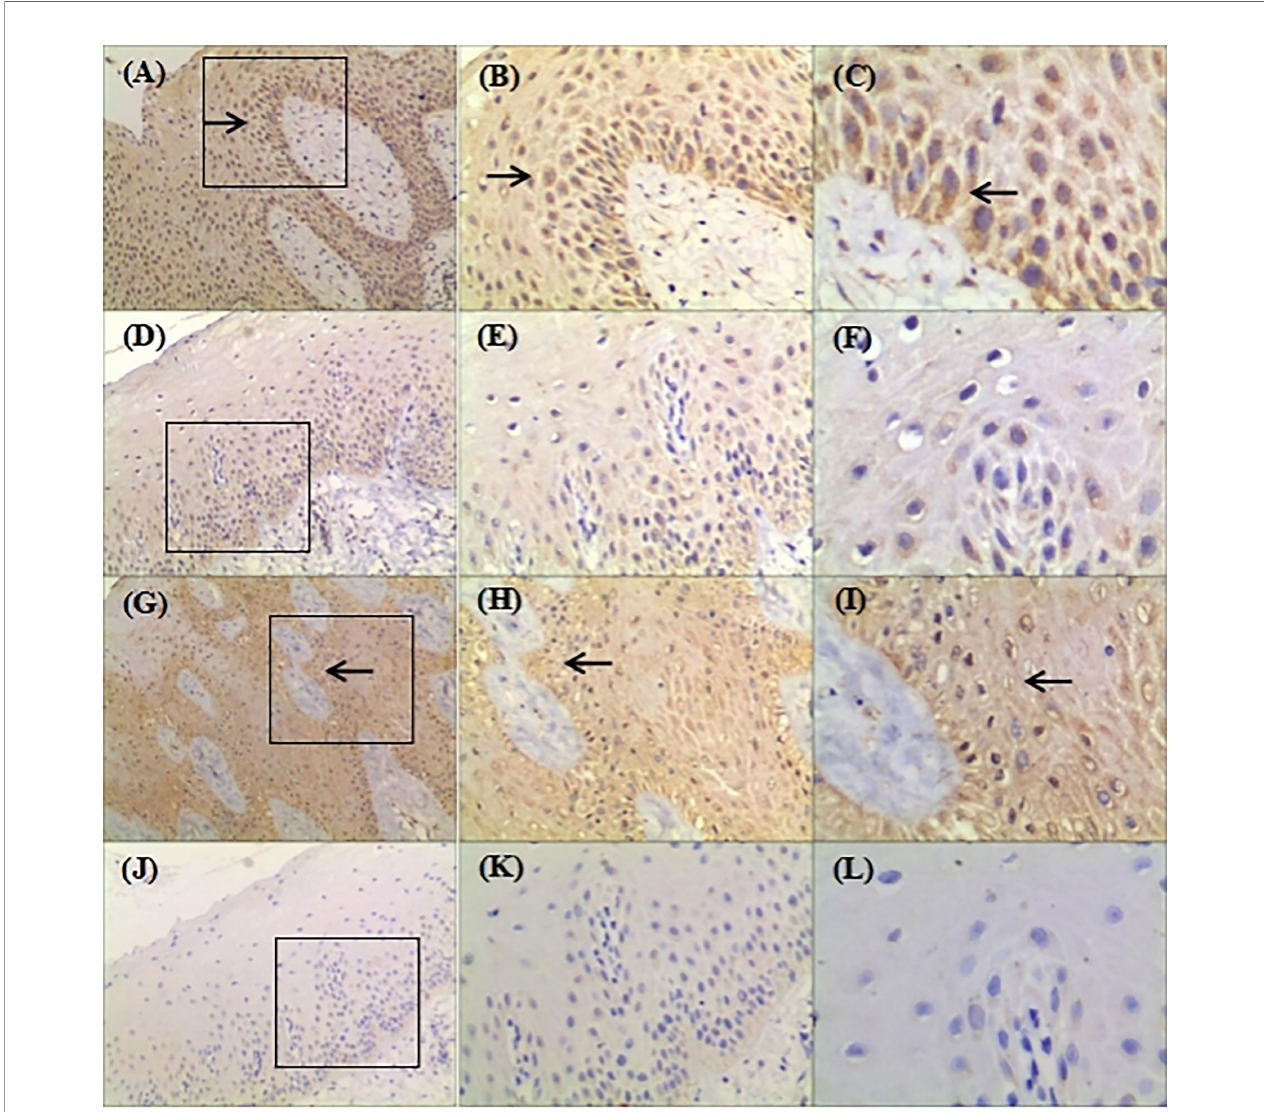
FIGURE 4 | Representative images showing expression of hBD-2 and hBD-3 in gingival tissue samples from the family (original magni fi cation ×100, ×200, ×400). (A – F) : Gingival samples were stained with rabbit polyclonal IgG antibody to hBD-2 (1:300) using standard IHC protocol; Circled areas in (A) was ampli fi ed in (B) and (C) ; (D) was ampli fi ed in (E) and (F) ; (A – C) were derived from patient with NHGF; (D – F) were derived from a healthy control gingival biopsy; (C) hBD-2 was detected in the cytoplasm; Arrows indicate positive staining. (G – L) : Gingival samples were stained with rabbit polyclonal IgG antibody to hBD-3 (1:400) using standard IHC protocol; Circled areas in (G) was ampli fi ed in (H, I) ; (J) was ampli fi ed in (K, L) ; (G – I) were derived from patient with NHGF; (J – L) were derived from a healthy control gingival biopsy; (I) hBD-3 was detected in the nuclei and cytoplasm. Arrows indicate positive